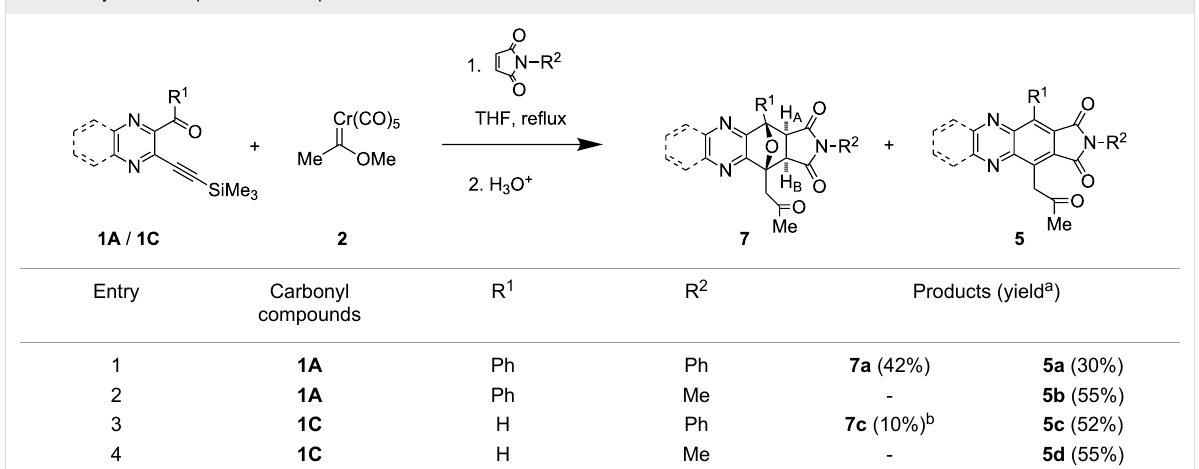
Table 1: Synthesis of quinoxaline and phenazine